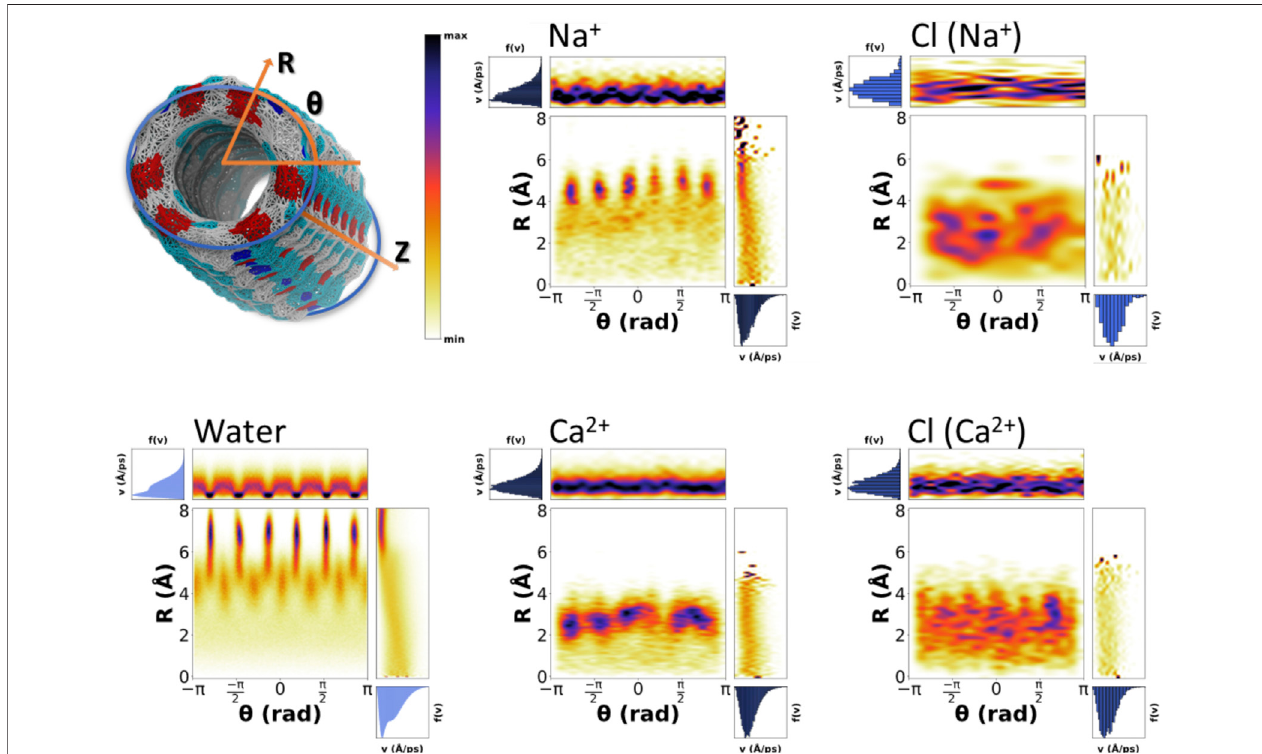
FIGURE9| Position – velocitycorrelationdiagramsforwater(bottomleft),selectedcations(middletop,Na + ,anddown,Ca 2+ ),andcorrespondentcounterions(right column).Thecentralplotofeachdiagramcorrespondstotheprobabilityofpositionsasafunctionofcylindricalcoordinates(R, θ ),thetopplotisthevelocitydistributionas afunction oftheangle, andtheright plotisthevelocity distribution asafunctionofthedistancetothecenterofthenanotube symmetryaxis.Theanalysiswasgenerated using the last 180 ns of the MD